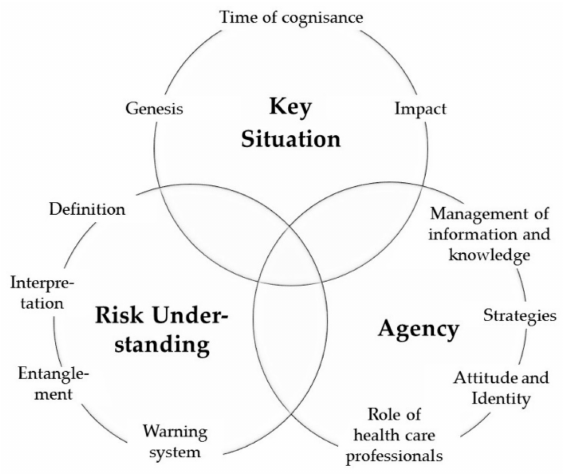
Figure 1. Central categories of dealing with disease risk: key situation, risk understanding, and